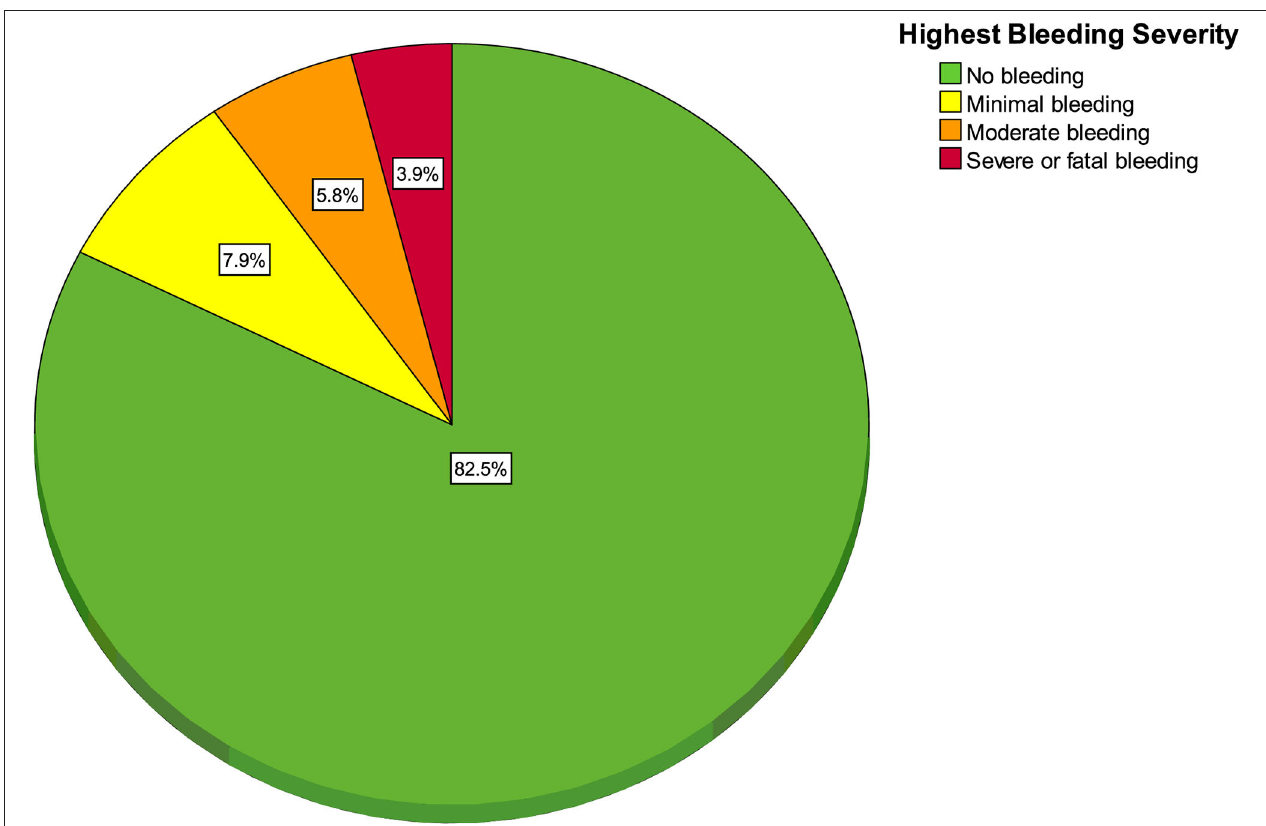
FIGURE 1 | Pie chart of highest bleeding severity ( n = 158 bleeding patients and 744 non-bleeding